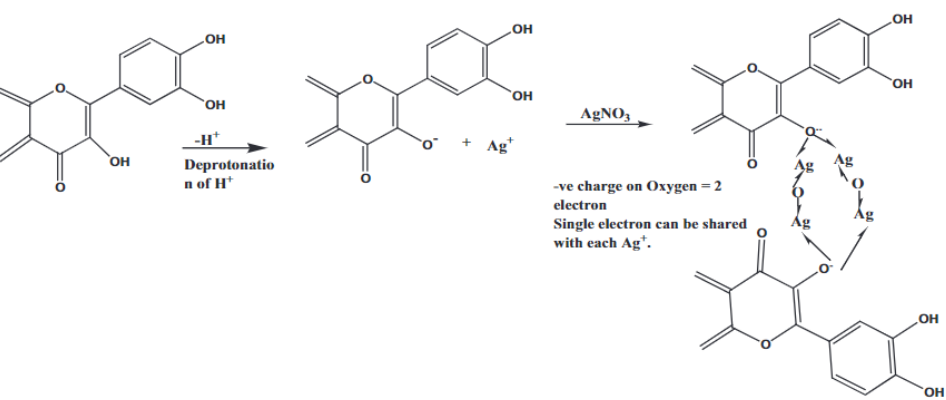
Figure 2. The reaction mechanism during the synthesis of Ag 2 O-NPs. Reprinted with permission from Ref. [29] Copyright 2020 Elsevier.